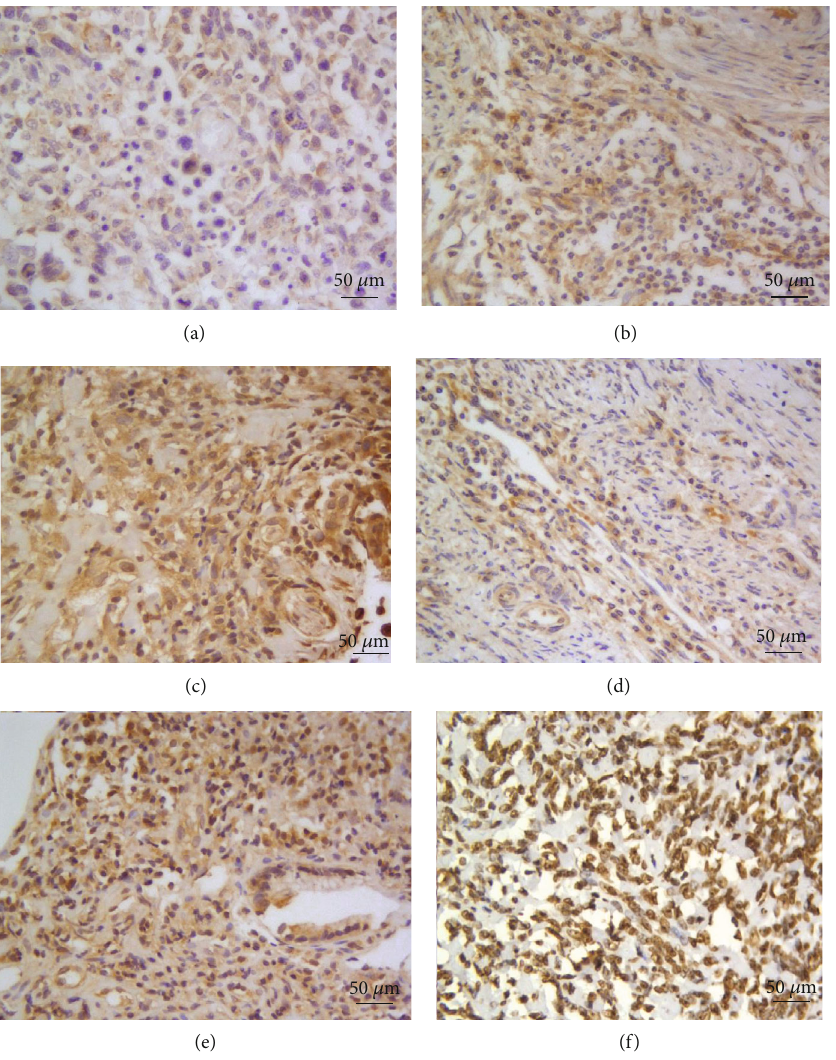
Figure 1: Representative immunohistochemical staining of HIF1 and JMJD2B. (a) Low expression of HIF1 in OS. (b) Moderate expression of HIF1 in OS. (c) High expression of HIF1 in OS. (d) Low expression of JMJD2B in OS. (e) Moderate expression of JMJD2B in OS. (f) High expression of JMJD2B in OS. Cells with positive expression were stained brown. Table 2: Correlation of HIF1 and JMJD2B